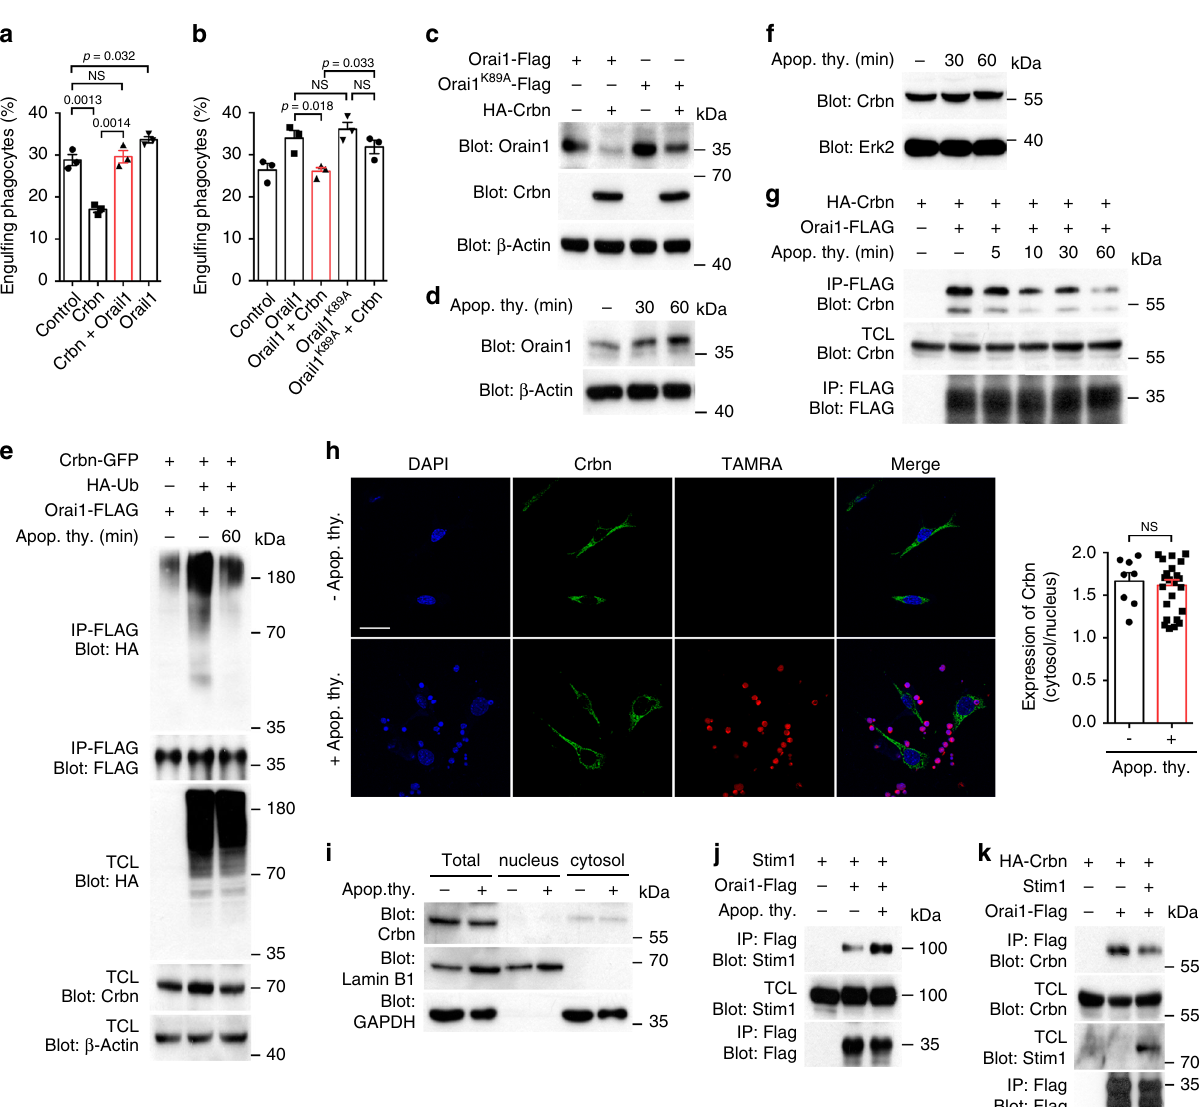
Fig. 6 The interaction of Orai1 with Crbn is attenuated during efferocytosis. a LR73 cells transfected with the indicated plasmids were incubated with TAMRA-stained apoptotic cells for 2 h and analyzed by fl ow cytometry. n = 3 experiments, mean ± SEM. The numbers in the graph indicate p values. NS not signi fi cant (one-way ANOVA). b The experiment was performed as in a . n = 3 experiments, mean ± SEM. NS not signi fi cant (two-tailed unpaired Student t test). c LR73 cells transfected with the indicated plasmids were lysed, and the proteins in the lysates were detected by immunoblotting. d BMDMs were incubated with apoptotic cells for the indicated durations were lysed, and the levels of Orai1 were detected with an anti-Orai1 antibody. e LR73 cells transfected with the indicated plasmids were incubated with apoptotic thymocytes for 60 min, and Orai1 ubiquitination were measured. f